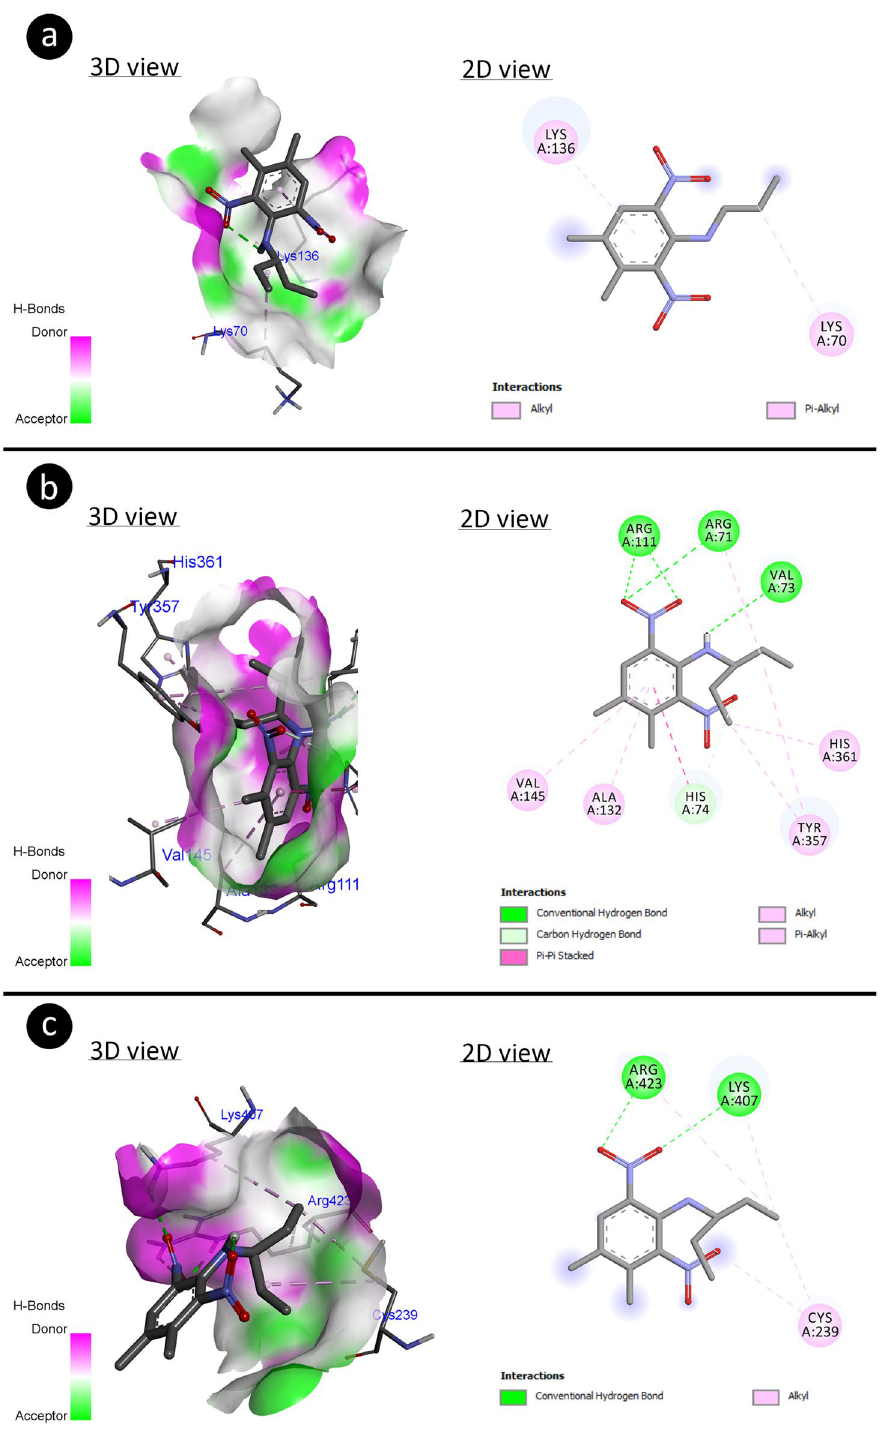
Figure 5. Potential molecular interactions of pendimethalin with antioxidant enzyme residues with different modes including H-bond ( a : SOD-pendimethalin, b : CAT-pendimethalin, c :